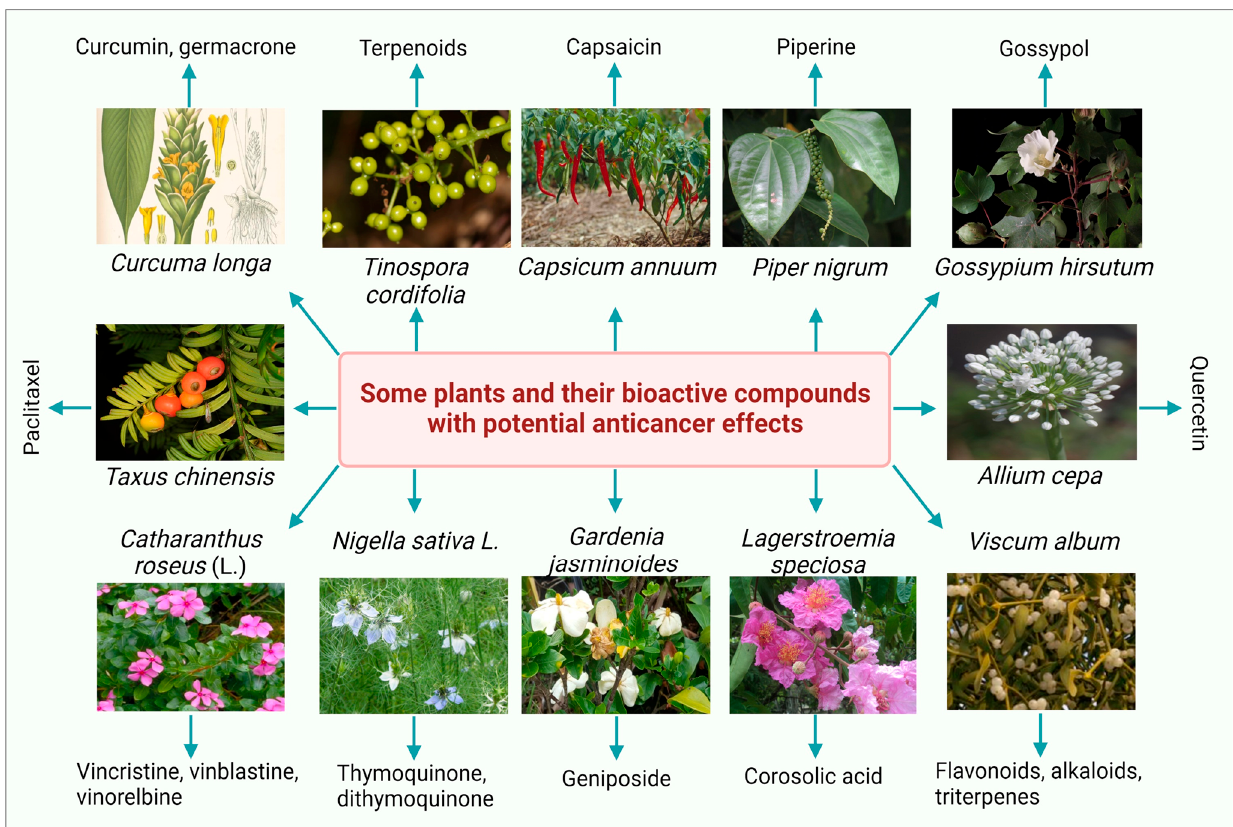
Figure 1. Some medicinal plants and their bioactive compounds having potential anticancer prop- erties.